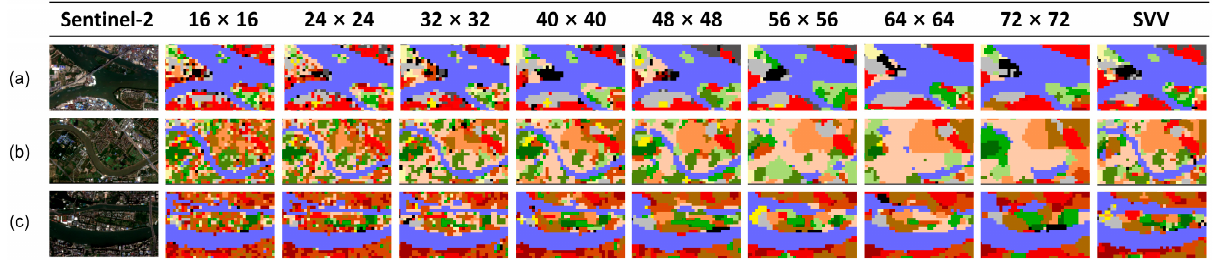
Figure 8. The samples produced by different ResNets and the SVS. ( a ) An island in Pear River, ( b ) and ( c ) different segments of Pear River.